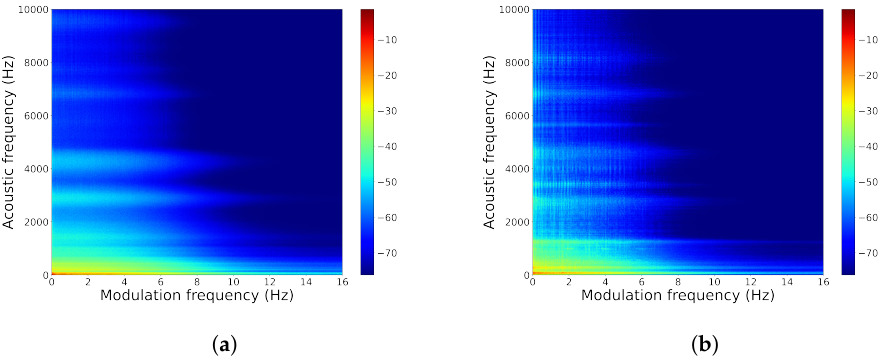
Figure 16. Modulation spectrogram of a segment, including ( a ) no noise and ( b ) speech